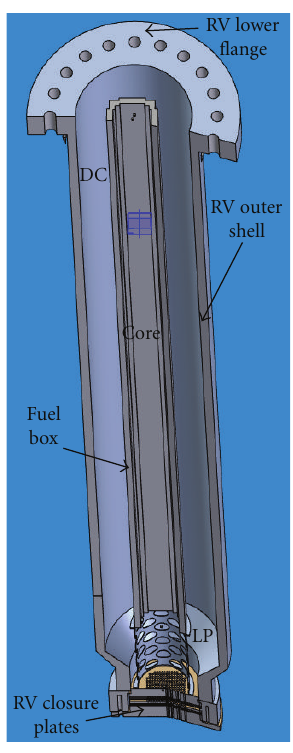
Figure 7: SPES3 fuel bundle box.